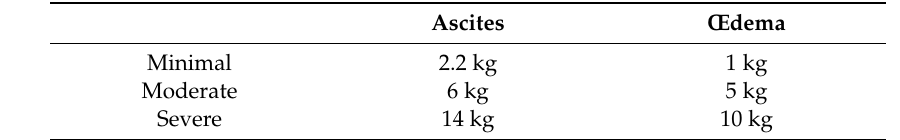
Table A2. Calculation of dry weight [116].